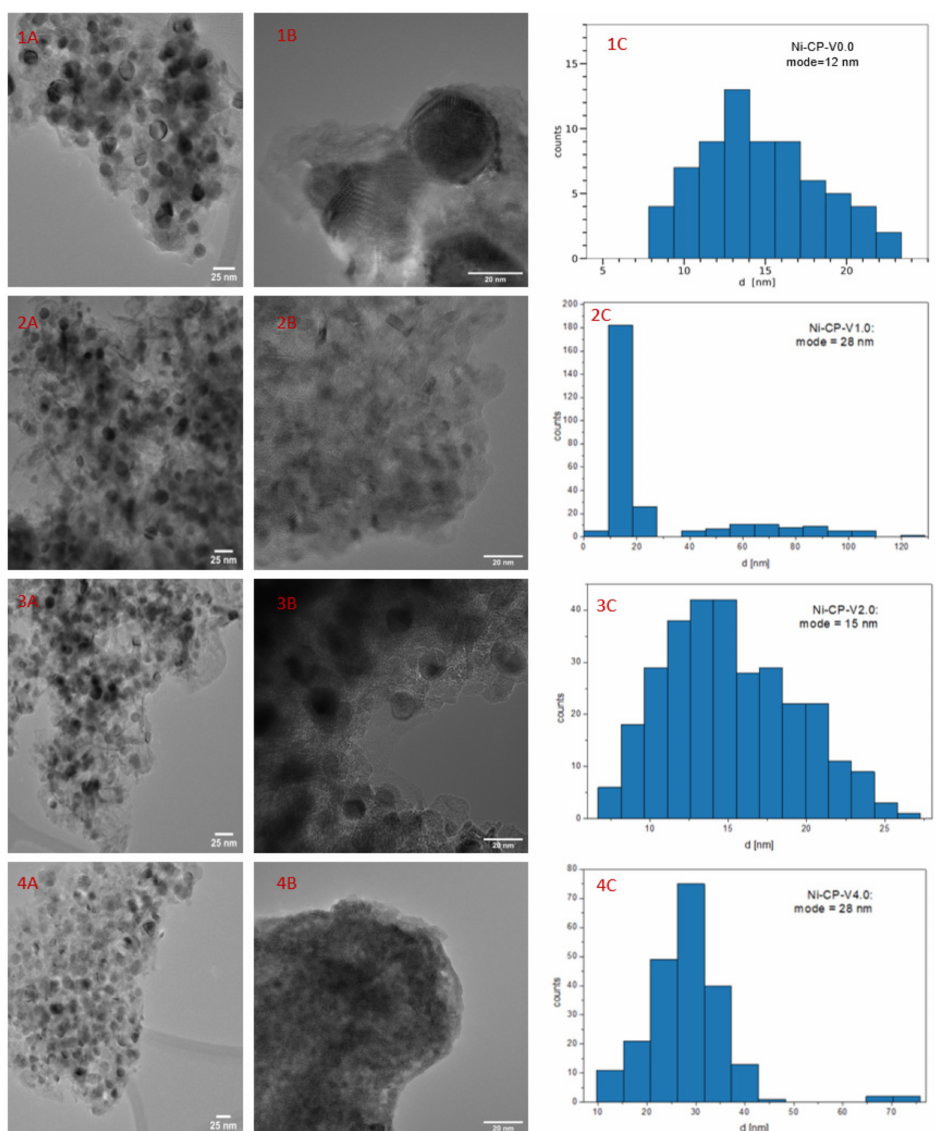
Figure 6. 1–4 ( A , B ) TEM images for the reduced hydrotalcite-derived samples; 1–4 ( C ) histograms for Ni 0 particle